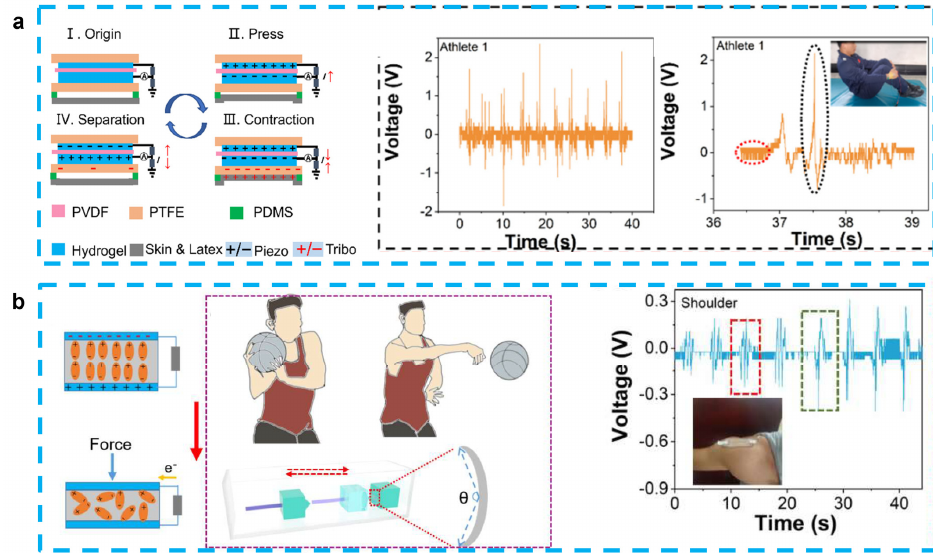
Figure 4. ( a ) A stretchable and self-healing hybrid nano-generator for human motion monitoring: coupling mechanism of TENG and PENG, outputting voltage and details of Athlete 1’s 301C diving motion. (Reprinted with permission from Ref. [81], Copyright 2021, MDPI.) ( b ) A flexible and stretchable self-powered nanogenerator in basketball-passing technology monitoring: working mechanism and scene of TSB-PENG monitoring the body joint motion system, outputting piezoelectric voltage of TSB-PENG on the shoulder that does the bend-and-stretch motion. (Reprinted with permission from Ref. [82], Copyright 2021, MDPI.)